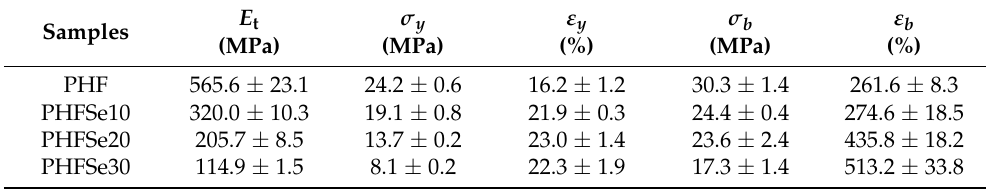
Table 4. Summary of the mechanical property of PHF and PHFDGA copolyesters.